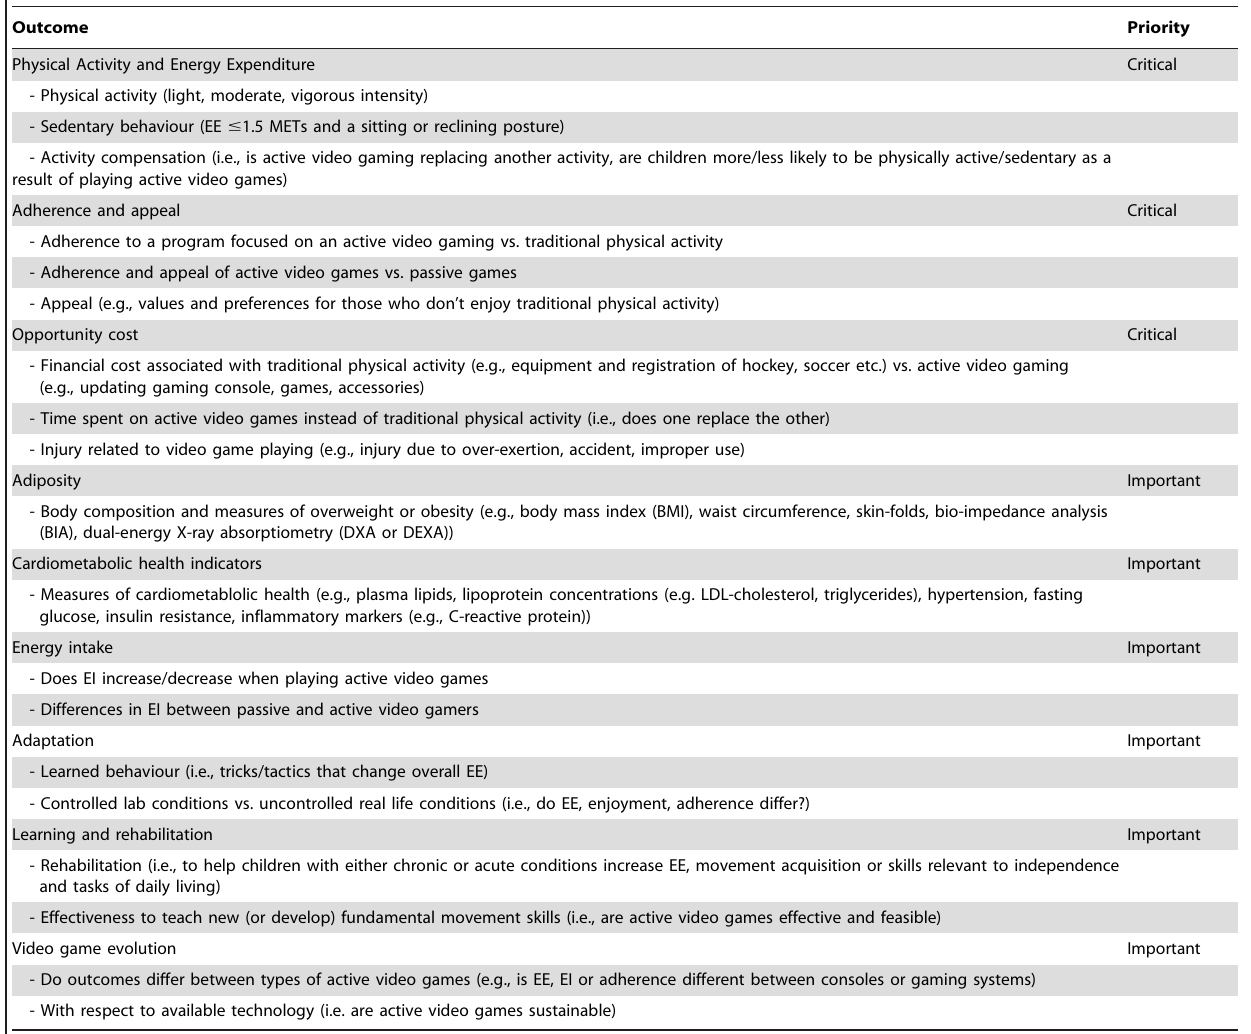
Table 2. A priori consensus rankings assigned by the Guideline Development and Research Committee for each health indicator by age